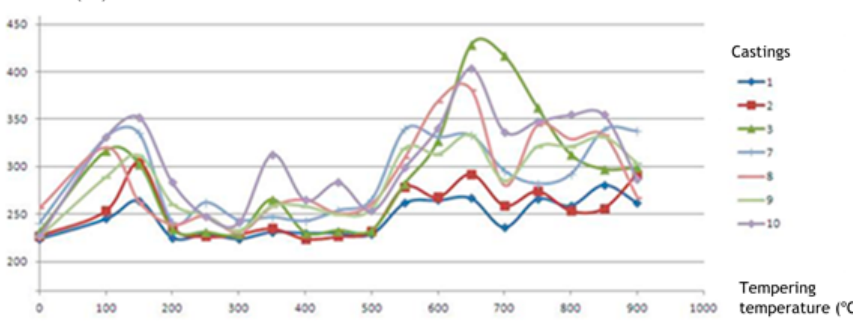
Figure 3. Detail of Figure 2 without castings 4–6, which showed a high transformation of austenite in other constituents.